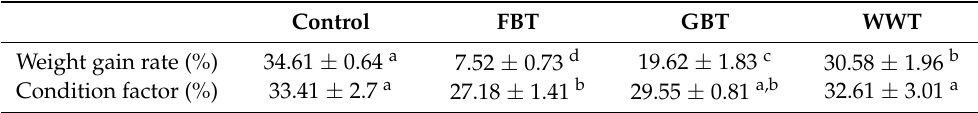
Table 2. Growth performance of grass carp in different